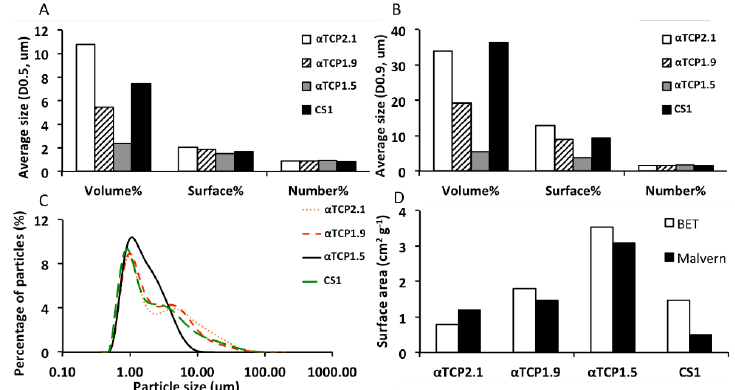
Figure 2. Particle size distribution of PMC precursors. The particle size limit of each PMC precursor (calcium salt) below which, based upon number, surface, and volume average calculations, ( A ) 50% (D0.5) or ( B ) 90% (D0.9) of all measured particles fall. ( C ) A distribution plot of all PMCs using surface average calculations. The surface area of each PMC precursor ( D ), determined by BET (white bars) or laser diffraction (black bars). Each αTCP (i.e., αTCP2.1) refers to the average particle size (D0.5, surface, in micrometers) of the calcium salt portion of PMC.